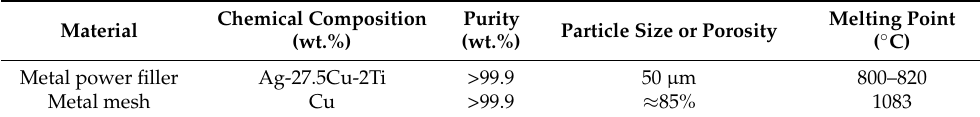
Table 1. Parameters of filler power and copper mesh.